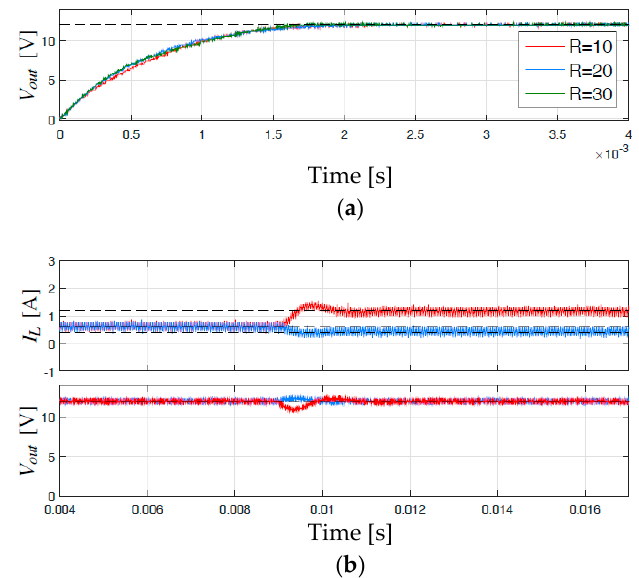
Figure 15. ( a ) Step responses under different output loads (10 Ω , 20 Ω and 30 Ω ), ( b ) inductor current and output voltage under load variation from 20 Ω to 30 Ω (blue), and from 20 Ω to 10 Ω (red).